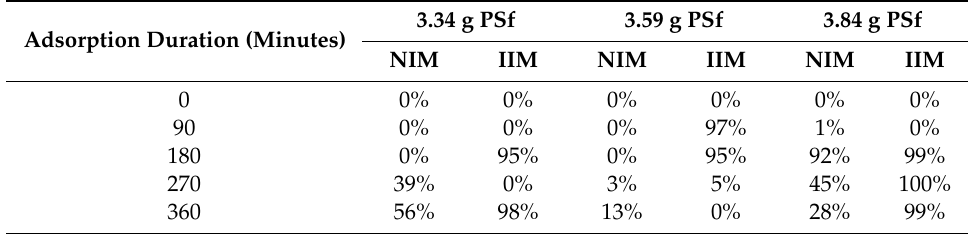
Table 2. Adsorption percentage of NIM and IIM with various PSf additions.